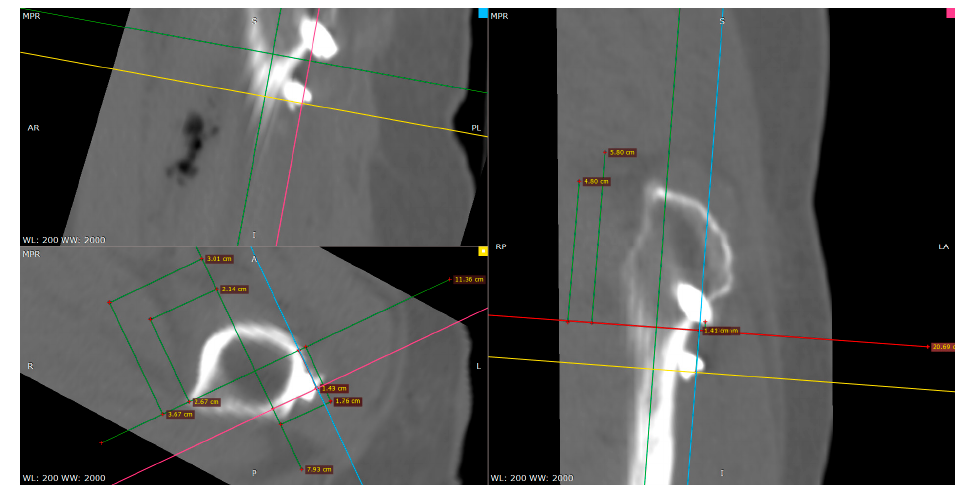
Figure 11. Using software RadiAnt to measure the position of the Hansson pin.